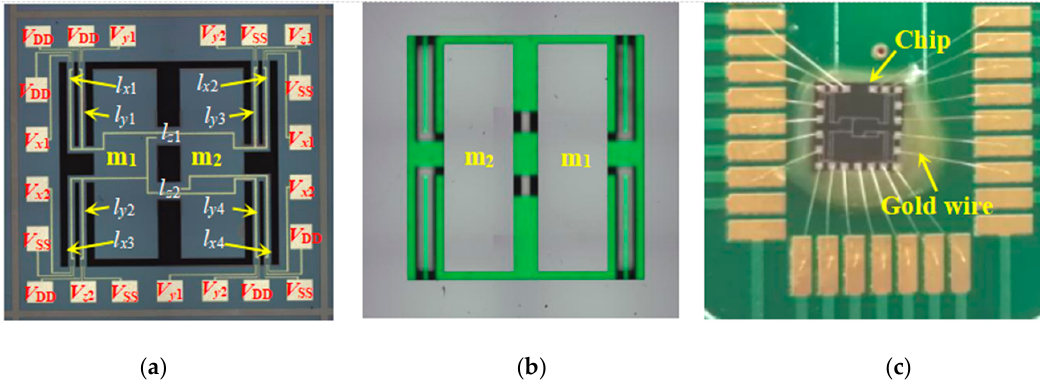
Figure 6. The photograph of the proposed chip: ( a ) top view; ( b ) bottom view; and ( c ) packaged chip.